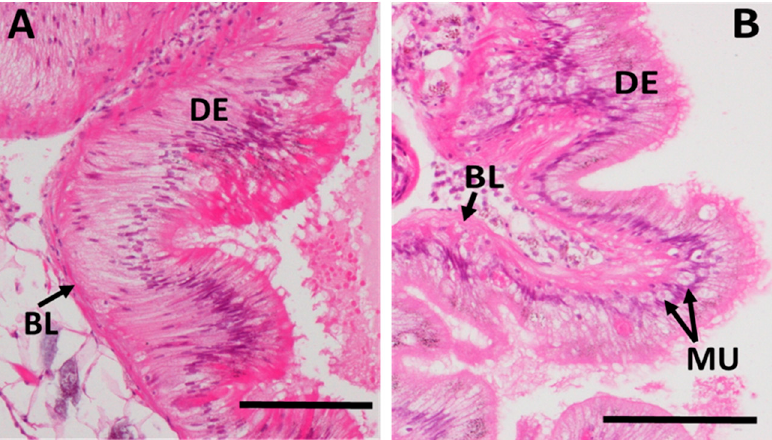
Figure 12. Sections of the stomach (digestive tract) stained with hematoxylin-eosin. ( A ) control periwinkle. ( B ) periwinkle of the CdH group after 21 days of exposure. Note the loss of integrity in the stomach epithelium (arrows) and the increase of mucocytes as a result of Cd-exposure. Scale bars: 200 µm; Abbreviations: DE: Digestive epithelia, BL: Basal lamina, MU: Mucocytes.